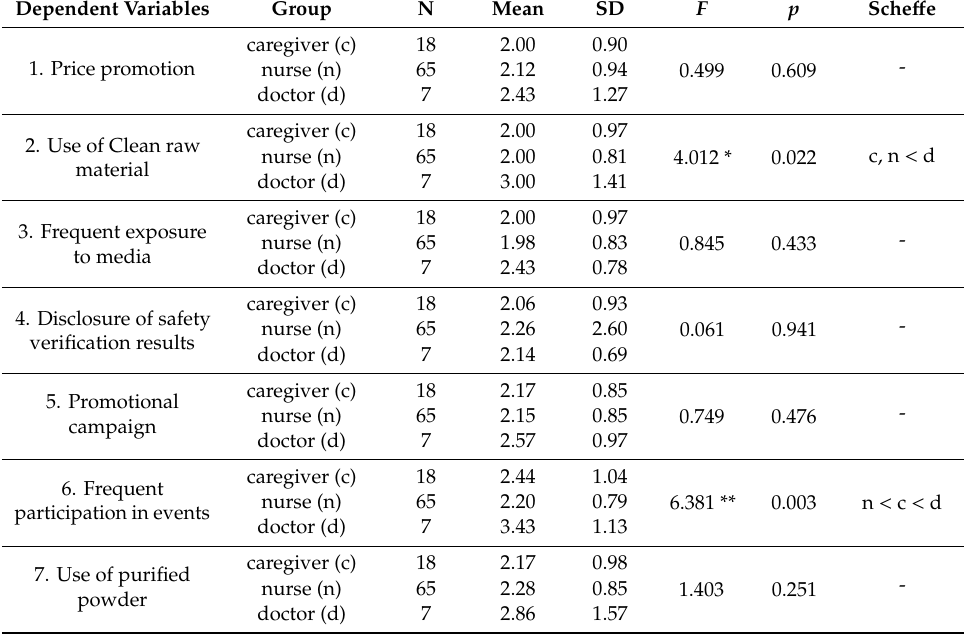
Table 4. Di ff erences in main variables according to healthcare professionals and Table 4. Differences in main variables according to healthcare professionals and caregivers.